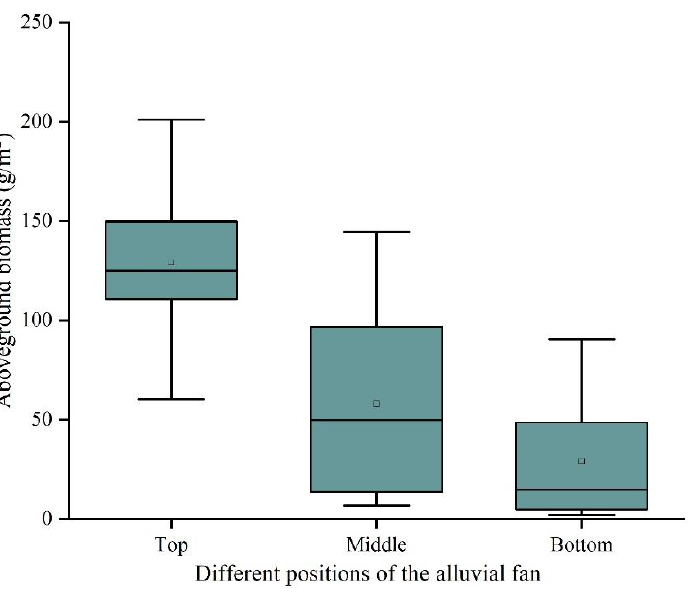
Figure 6. Box diagram of AGB at the alluvial fan of different positions.